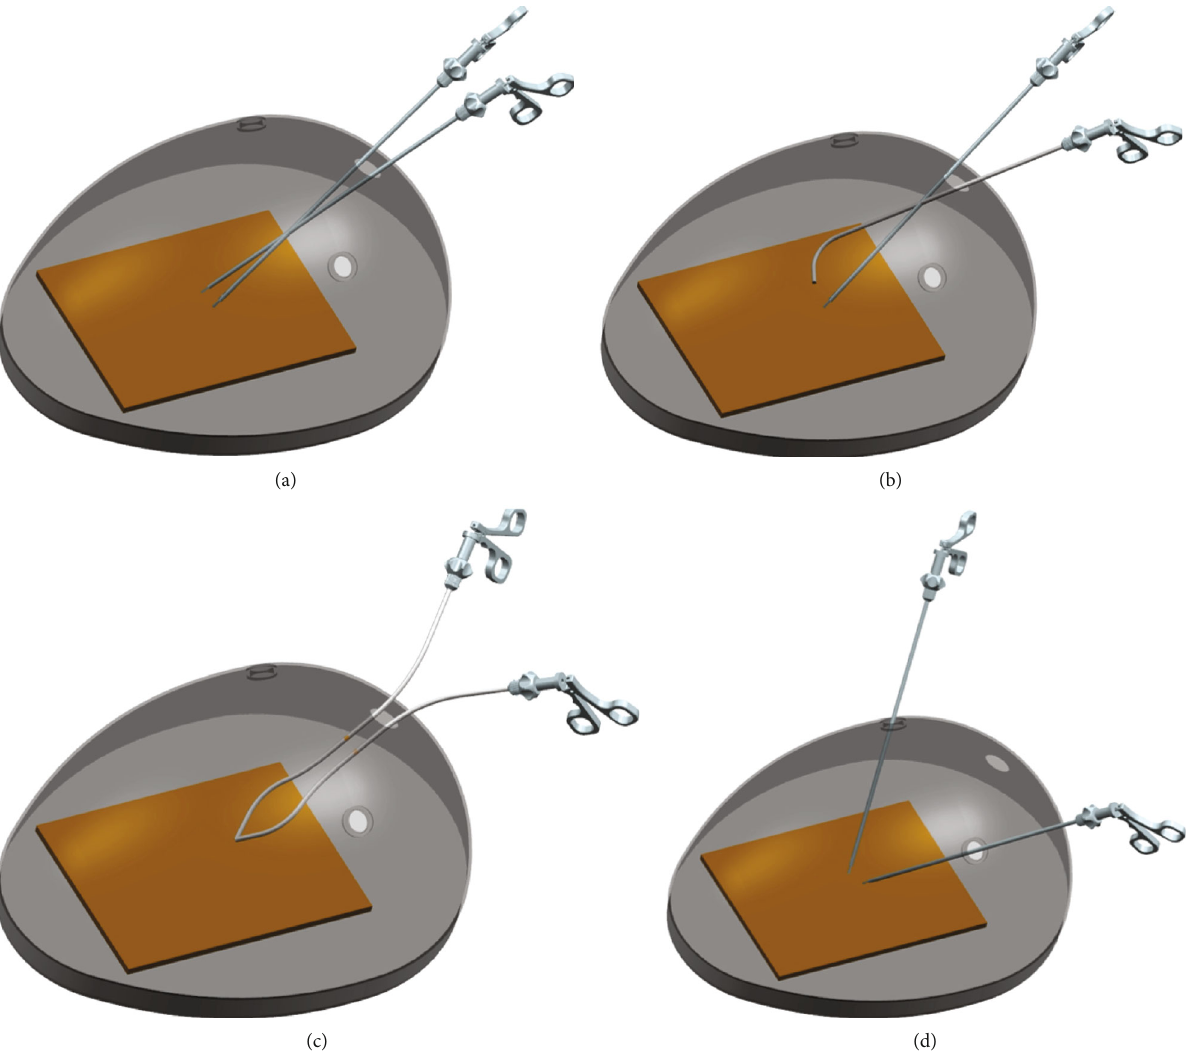
Figure 4: The schematic diagrams of the four groups of ABCD. (a) Group A, two straight instruments via SILS. (b) Group B, one straight instrument and one articulated instrument via SILS. (c) Group C, two precurved instruments via SILS. (d) Group D, two straight instruments via